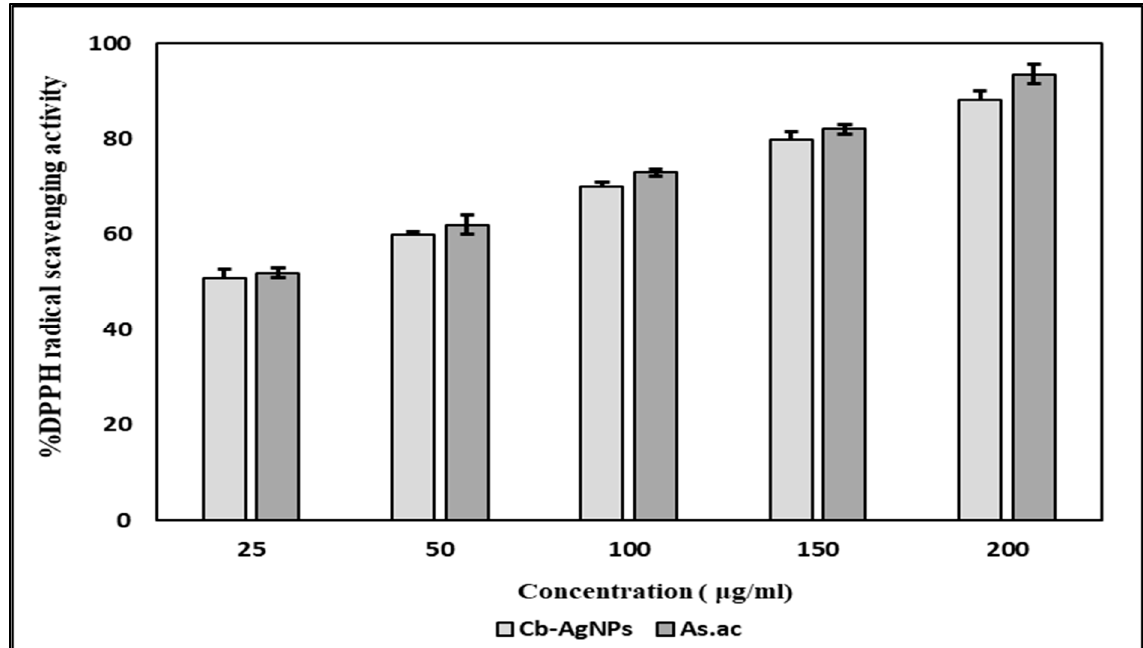
Figure 8. DPPH free radical scavenging ability of the synthesized cranberry Ag NPs.